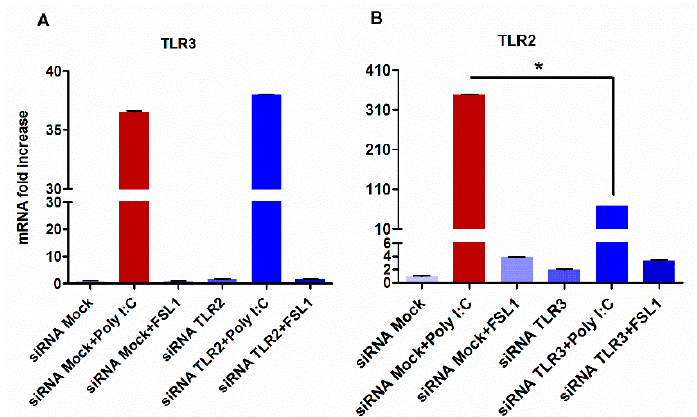
Figure 3. Silencing of the TLR3 reduced TLR2 gene expression in HGECs: when TLR2 was silenced, the expression of TLR3 was not affected after stimulation with poly I:C ( A ). On the other hand, silencing TLR3 downregulated TLR2 gene expression ( B ). Statistical test: one-way ANOVA followed by Tukey’s multiple comparison test (* p < 0.05) and the results are represented as the mean ± SE ( n = 3) from three independent experiments.